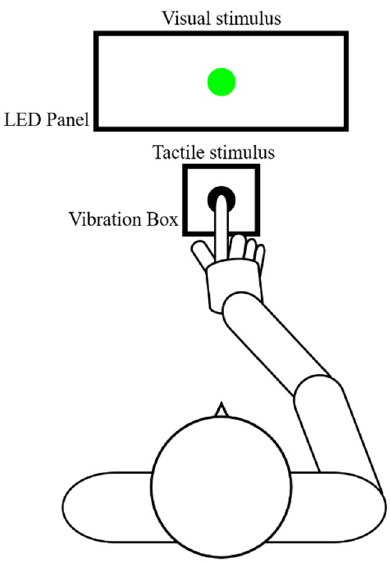
Figure 1. Temporal order judgment (TOJ) task. The task was presented to the child with a visuo-tactile TOJ device (Keio method, UT-0021, Medical Try System, Tokyo, Japan). This device includes an LED panel (UT-0021-2, Medical Try System, Tokyo, Japan) and vibration box (UT-0021-1, Medical Try System, Tokyo, Japan), which provided the visual and tactile stimuli, respectively. The child put the index finger of their preferred hand in the hole of the vibration box and touched the vibrotactile stimulator. Therefore, the child could not observe the tactile stimulus. The child was instructed to watch the LED panel. Conditions were set in the TOJ task device so that the visual stimulus was presented 0, 50 or 100 ms earlier than the tactile stimulus, or vice versa. A blackout curtain prevented the child from seeing outside the experimental chamber.